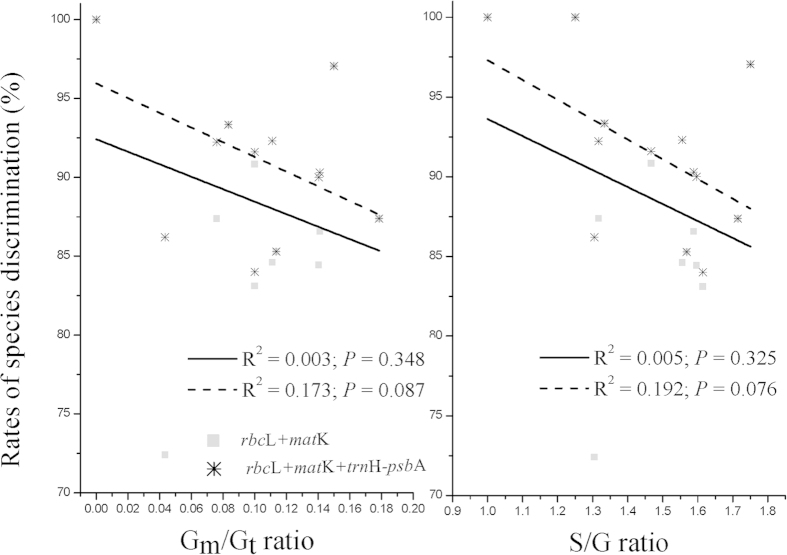
Correlations of closely-related taxa ratios with species discrimination rates of rbcL + matK and rbcL +  matK + trnH–psbA (left side: Gm/Gt ratios; right side: S/G ratios).